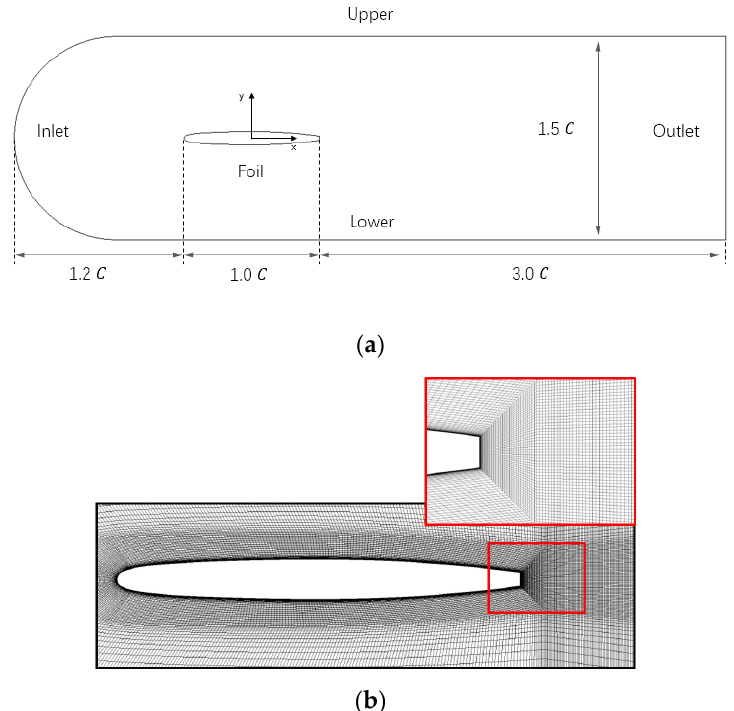
Figure 1. Computational domain with dimensions ( a ) and mesh topology close to the hydrofoil surface and near wake region ( b ).